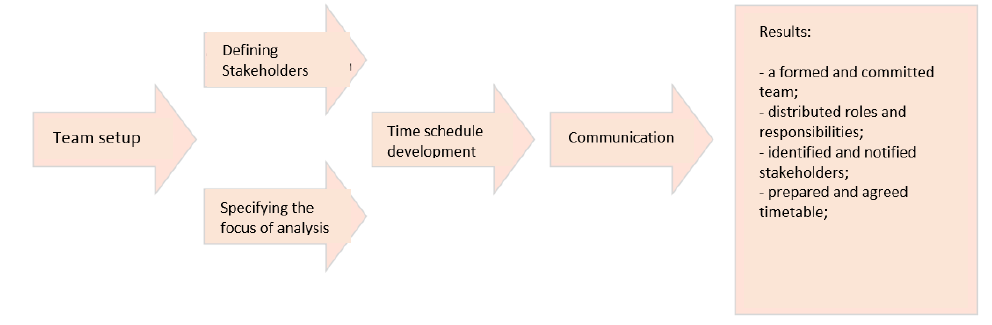
Figure 2: Stage 1 Activities